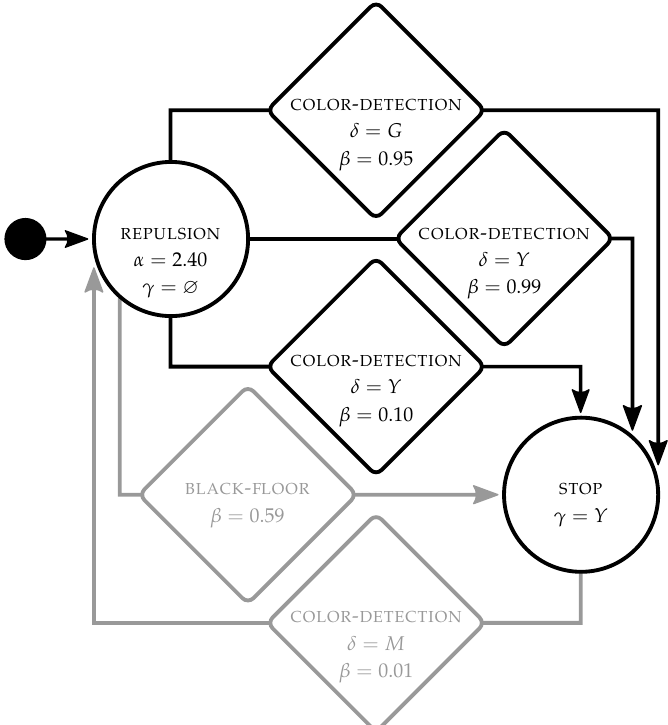
Figure 4. Instance of control software produced by TuttiFrutti for STOP . The probabilistic finite state machine shows the effective modules in black and non-reachable modules in light gray. Circular modules represent the low-level behaviors and rhomboid modules represent transition